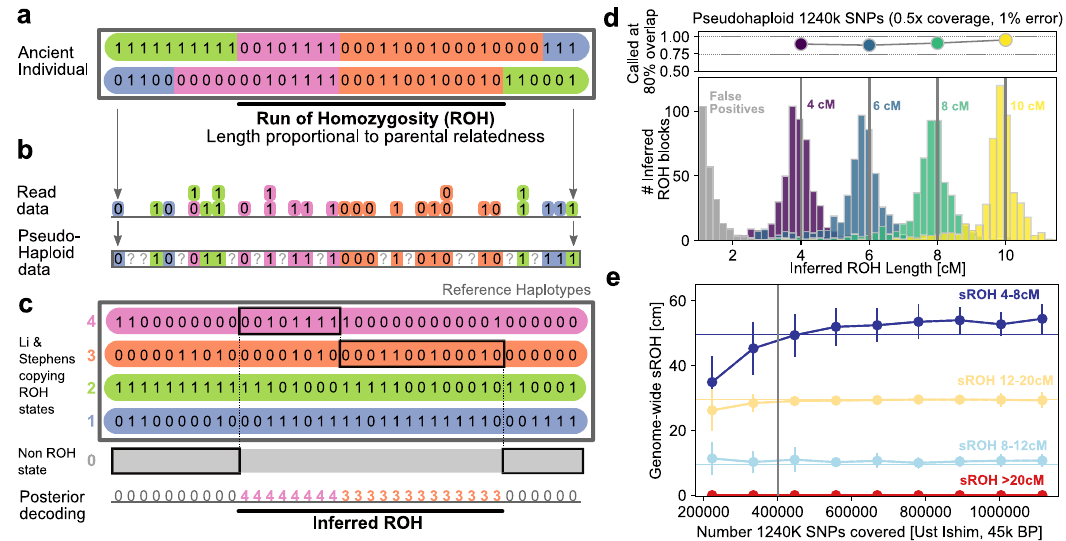
Fig. 1 Detecting runs of homozygosity using a reference panel. a Illustration of genotype data for a diploid individual. b Mapping sequencing reads to a biallelic SNP produces counts of reads for each allele, from which in turn pseudo-haplotype genotypes, i.e., single reads per site, are sampled. c Schematic of Method. A target individual ’ s genotype data is modeled as mosaic copied from haplotypes in a reference panel (ROH states, colored) and one additional background state (non-ROH, gray). d We applied our method to simulated data with known ROH copied in (see Supplementary Note 1.7 for details). We copied 500 ROH of exactly 4, 6, 8, and 10cM into 100 arti fi cial chromosomes, and depict histograms of inferred ROH lengths (in color) as well as false positives (in gray) after downsampling and adding errors (0.5× of all 1240K SNPs, with 1% error added). e Down-sampling experiment of a high coverage ancient individual who lived 45,000 years ago (Ust Ishim man) using a modern reference panel (1000 Genomes dataset). We down-sampled pseudohaploid data at the 1240K SNPs. For each target coverage, we ran 100 independent replicates and depict the mean and standard deviation of the inferred ROH in four length bins (4 – 8, 8 – 12, 12 – 20, and >20cM). The horizontal lines indicate high con fi dence estimates using diploid genotype calls from all available